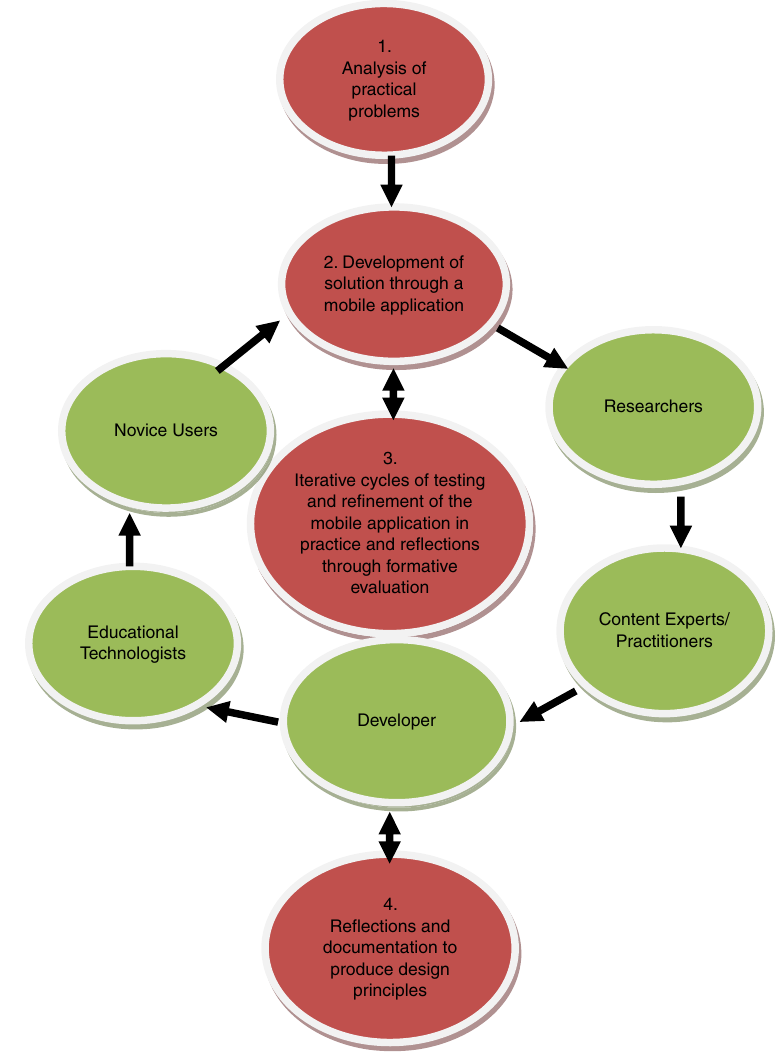
Figure 1. Design-based research model of this